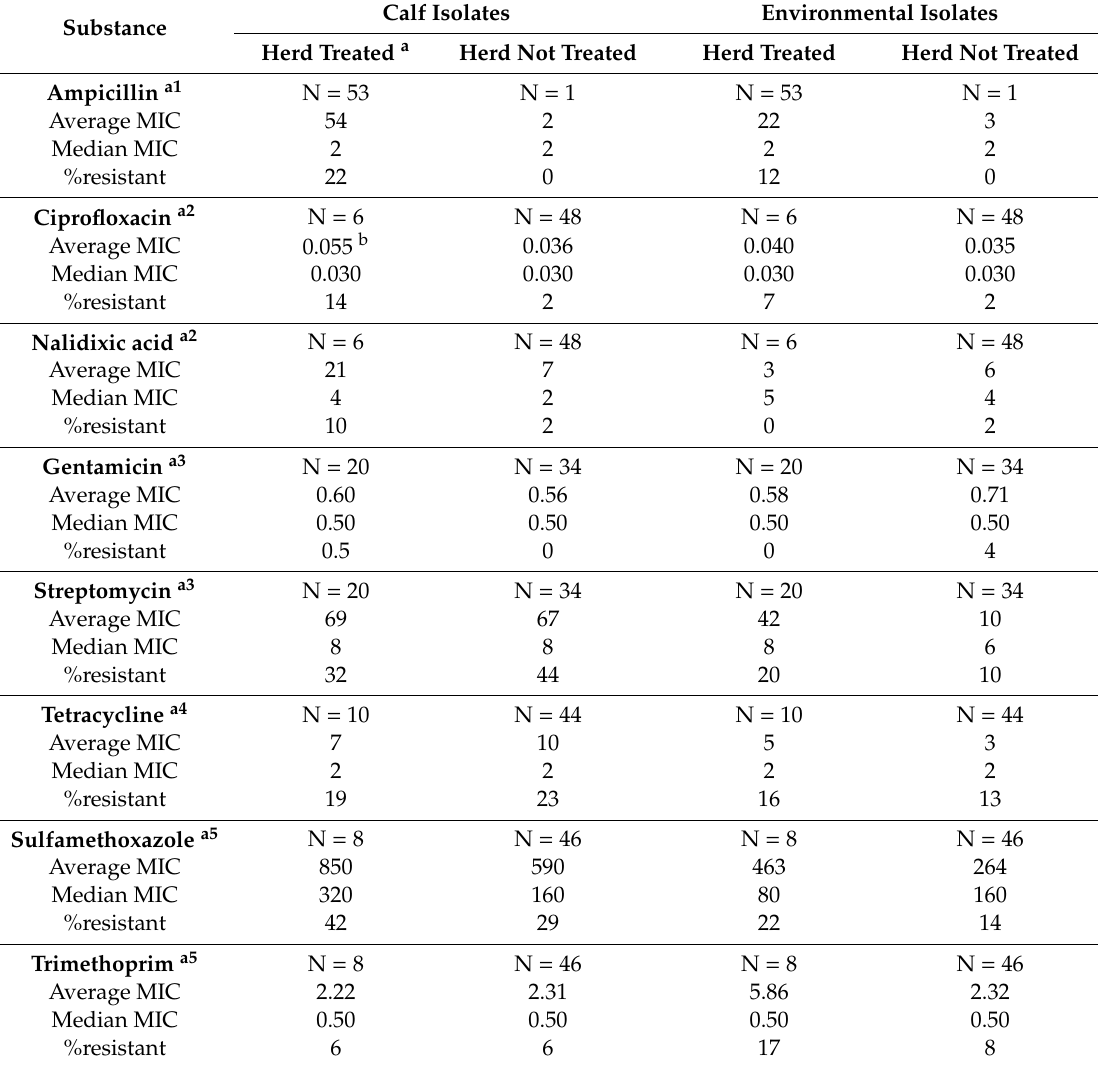
Table1. Summaryofantimicrobialsusceptibilitytestresultsfor Escherichiacoli isolatesfromfecalsamples from calves and environment (manure drainage and manure pit) in 27 organic and 27 conventional Swedish dairy herds (sampling period 2) and the corresponding use of antimicrobial treatments in these herds, as determined by collection of empty drug packages. Treated = use of the corresponding substance recorded for the herd. Not treated = no use of the corresponding substance